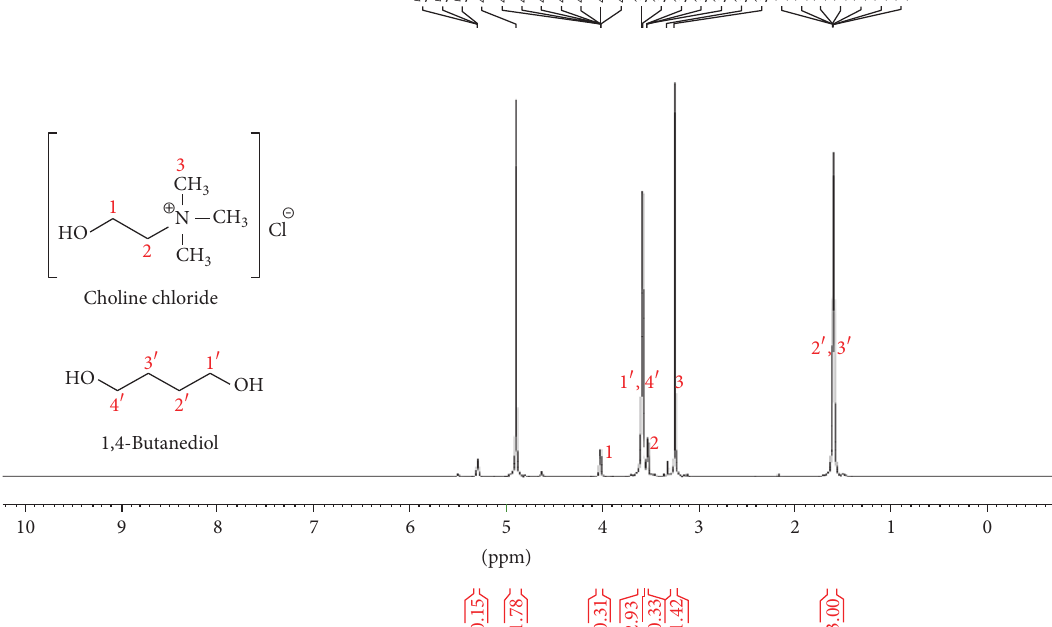
Figure 4: 1 H NMR spectrum of alcohol-based